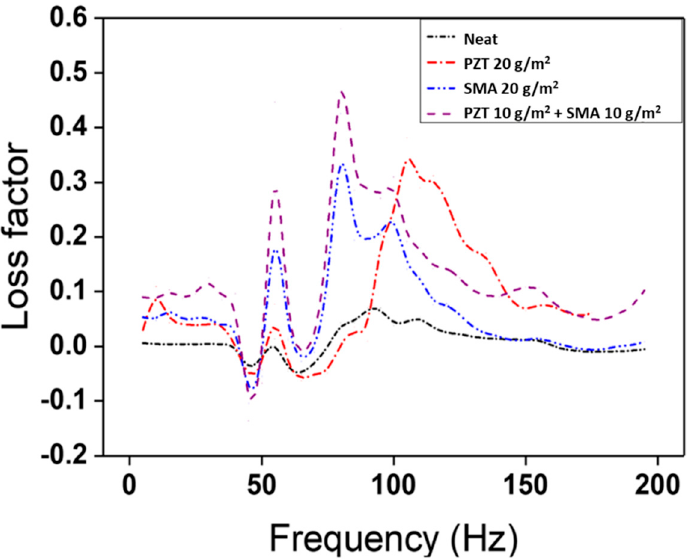
Figure 9. Loss factors (tan δ ) of CFRP specimens with PZT, SMA and PZT/SMA mixed particle- dispersed mixture film. Measurement data for varying frequencies and different particle loadings.